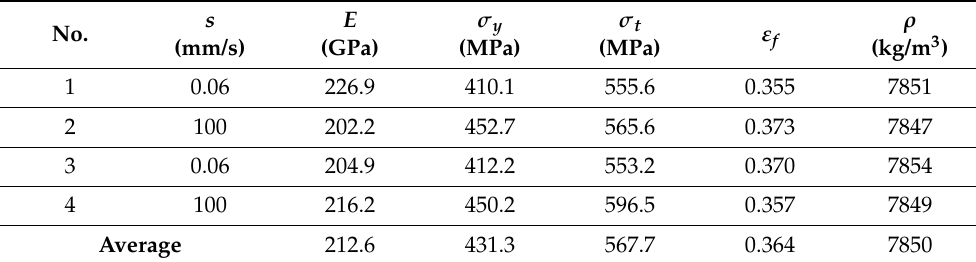
Table 5. Mechanical properties of specimens (AH36).